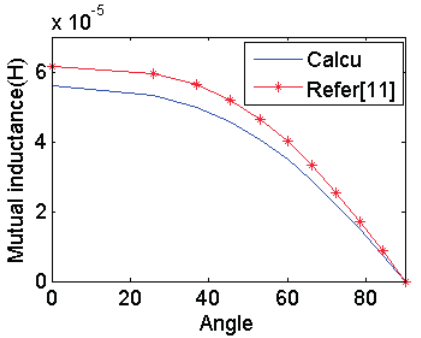
Figure 10. Mutual inductance simulation